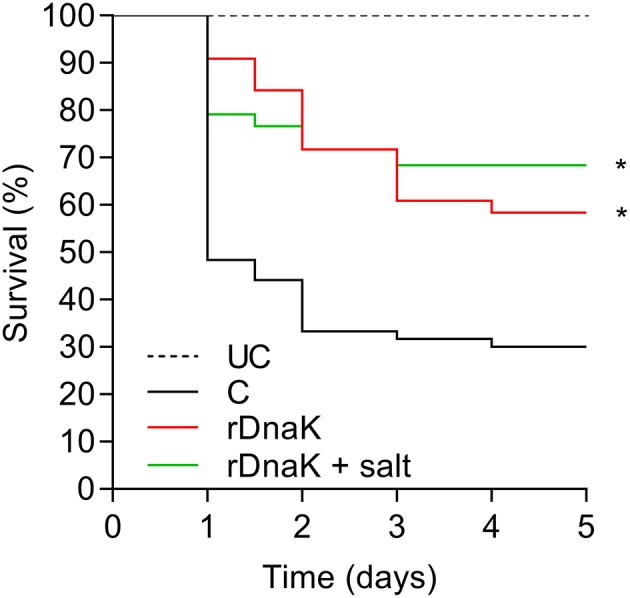
The impact of year-two immunization protocols on the protection of channel catfish against an F. columnare laboratory challenge. Kaplan-Meier survival curves of catfish challenged with isolate LV-359-01 over 5 days. The different groups are labeled as indicated in the figure. Data represent cumulative mortality across three replicate tanks per treatment containing 120 fish (n = 40/tank). Asterisk(s) denote a significant difference in survival when compared to the non-immunized control group; *P < 0.05.